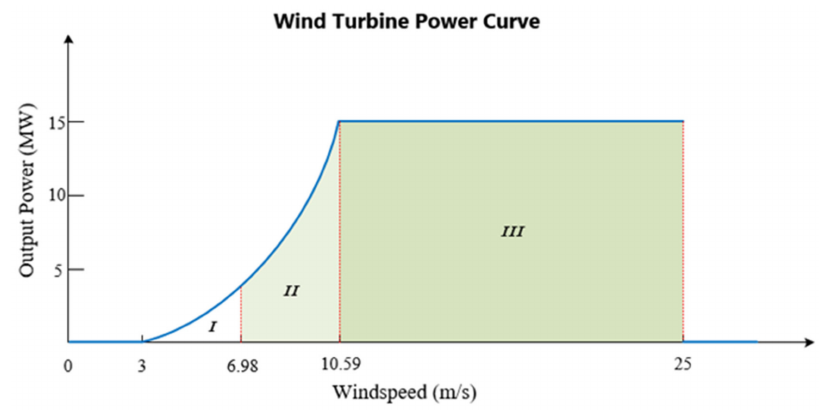
Figure 9. 15 MW Wind-Turbine Power Curve.